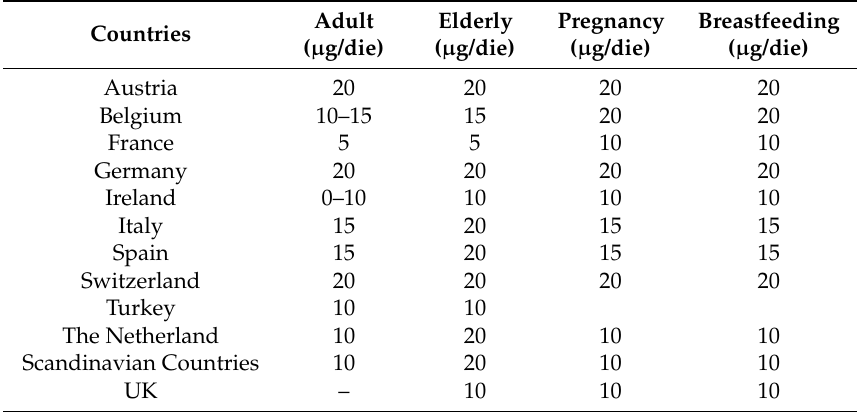
Table 3. Recommended intakes for vitamin D in adult and elderly population, and in pregnant and breastfeeding women, in some European countries. Modified from